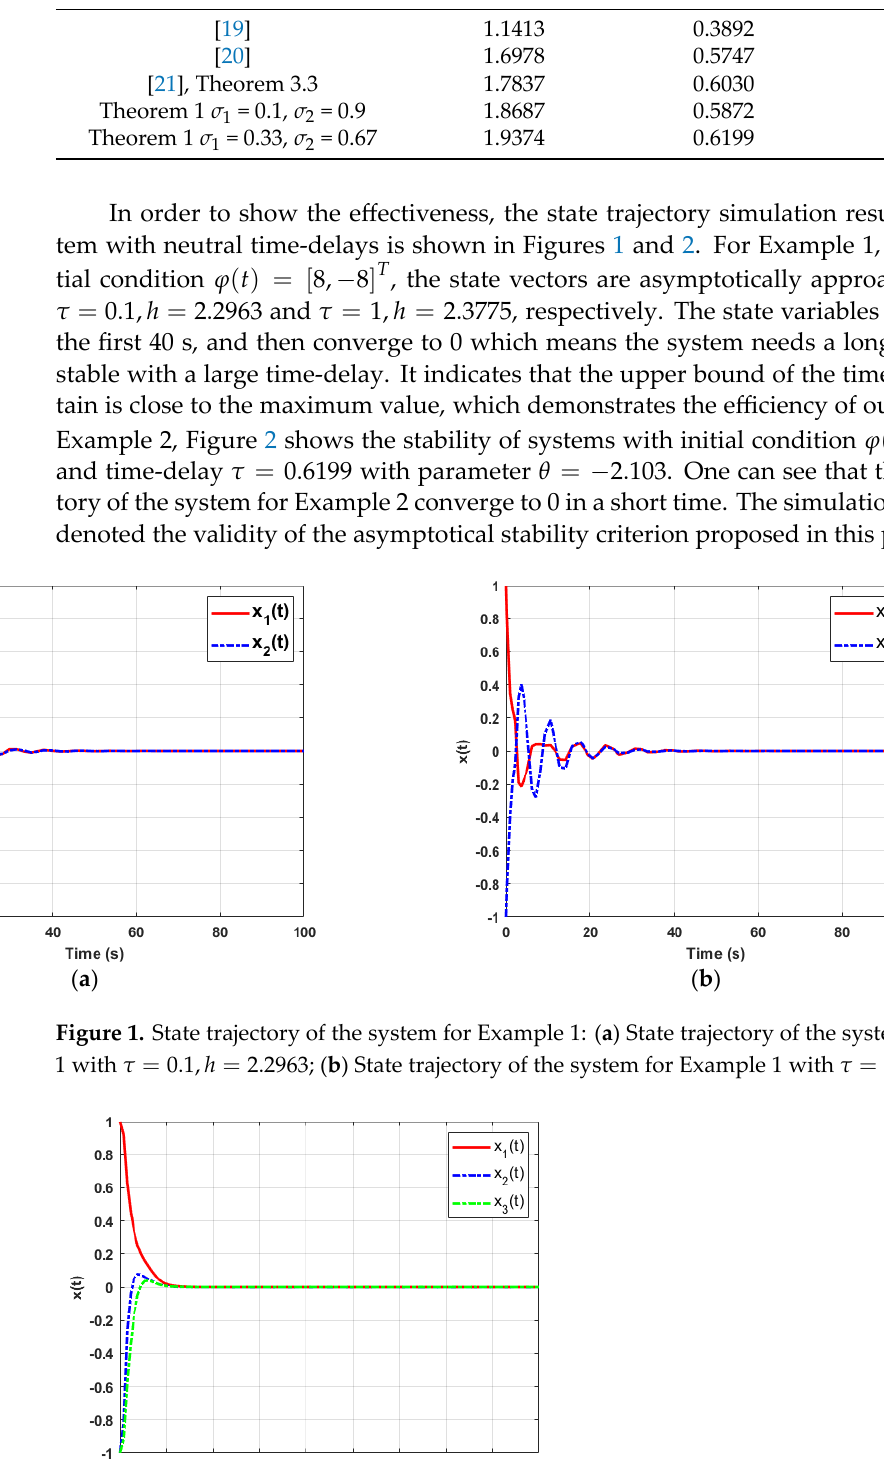
Figure 2. State trajectory of the system for Example 2 with